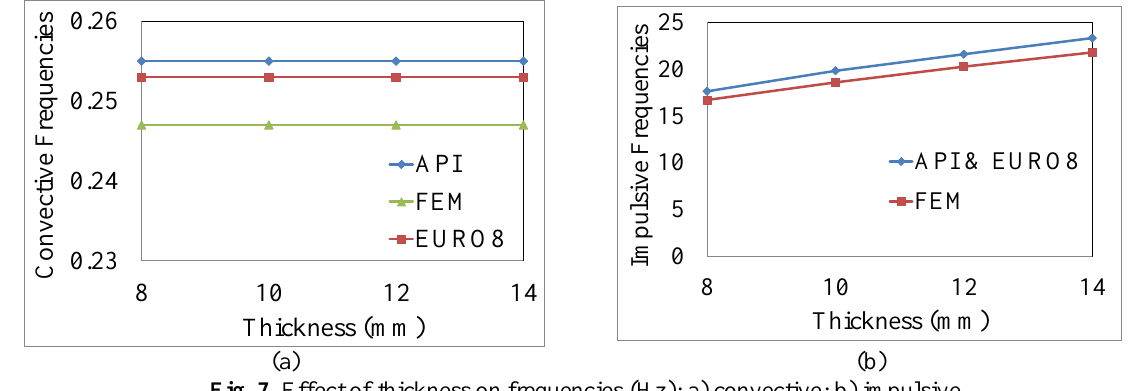
Fig. 7. Effect of thickness on frequencies (Hz); a) convective; b)